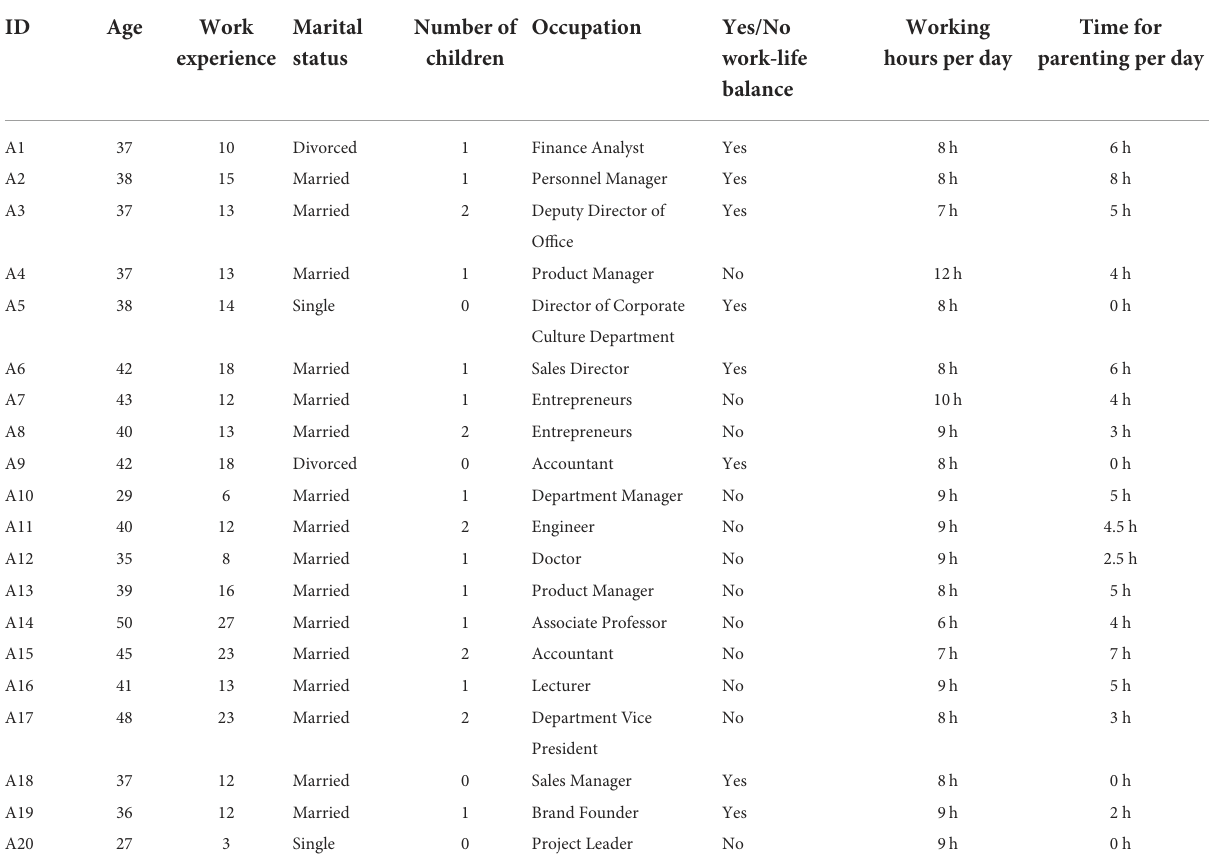
TABLE 1 Demographic characteristics of the